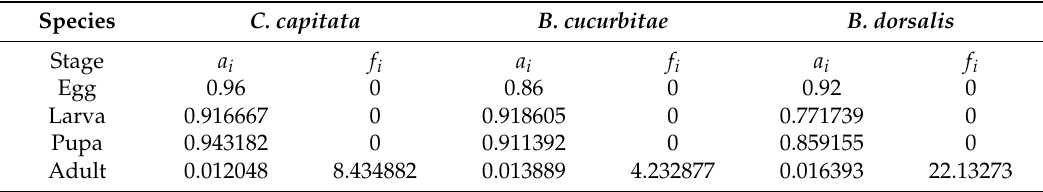
Table 1. Life history values for three tephritid species used in model.